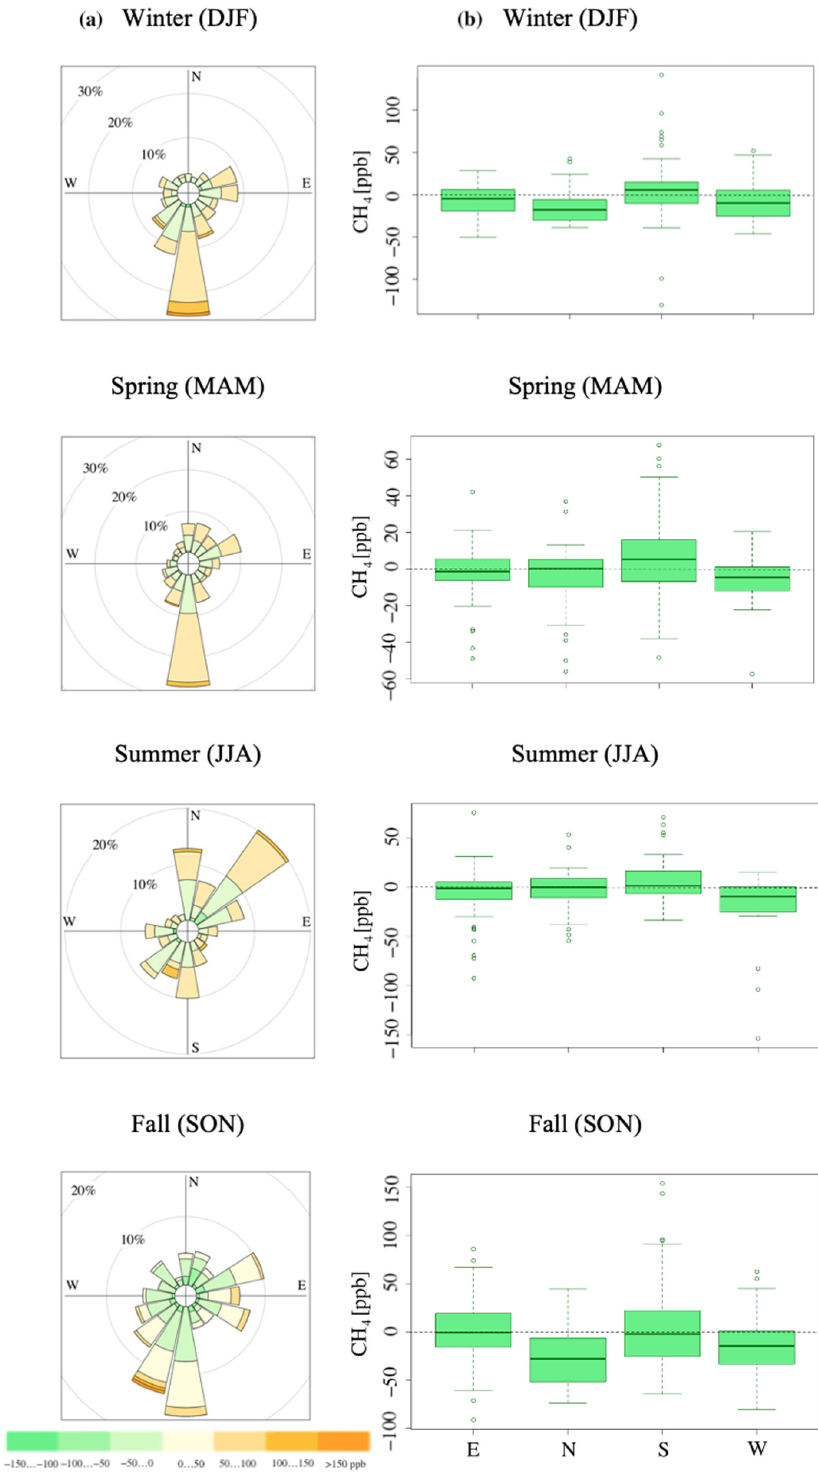
Figure 8. Angular distribution of atmospheric CH 4 anomalies for the period of observations at the measurement station “DIAMIS”: ( a ) frequency of counts (%) and dry mole fractions (ppb). Afternoon data records for CH 4 (1–4 pm LT) are presented; ( b ) distribution of atmospheric CH 4 anomalies throughout the year along with four geographical domains, where negative values ( − indicate an uptake of CH 4 , and positive values (+) indicate a release of CH 4 . For each box, the central line indicates the median, the bars represent the lower ‘hinge’ and the upper ‘hinge’ and the extremes of the upper and lower whiskers. Dots indicate